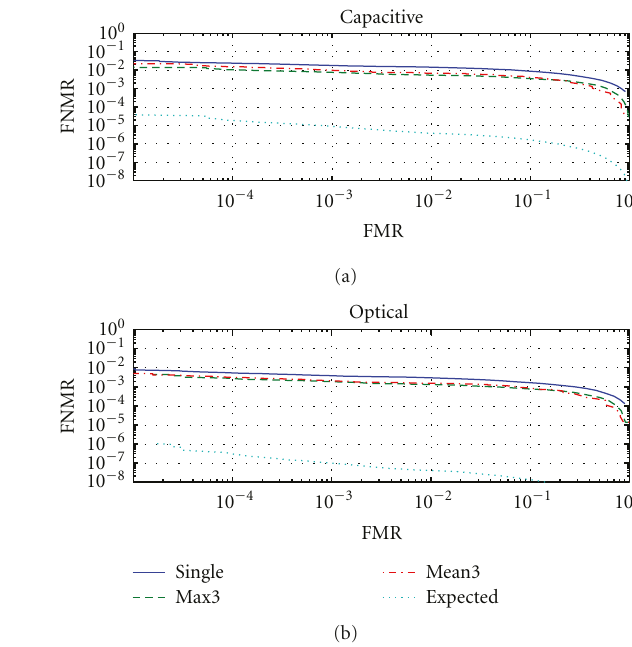
Figure 4: DET curve for the capacitive sensor (a) and the optical sensor (b) based on the balanced database. The solid line represents the FMR/FNMR tradeo ff for a single attempt. The dashed lines represent the performance based on the maximum comparison score of 2 attempts (max2); the dash-dotted lines represent the performance for the mean comparison score across 2 attempts (mean2). The dotted curve represents the expected FMR/FNMR tradeo ff assuming constant false nonmatch and false match probabilities for each trial.